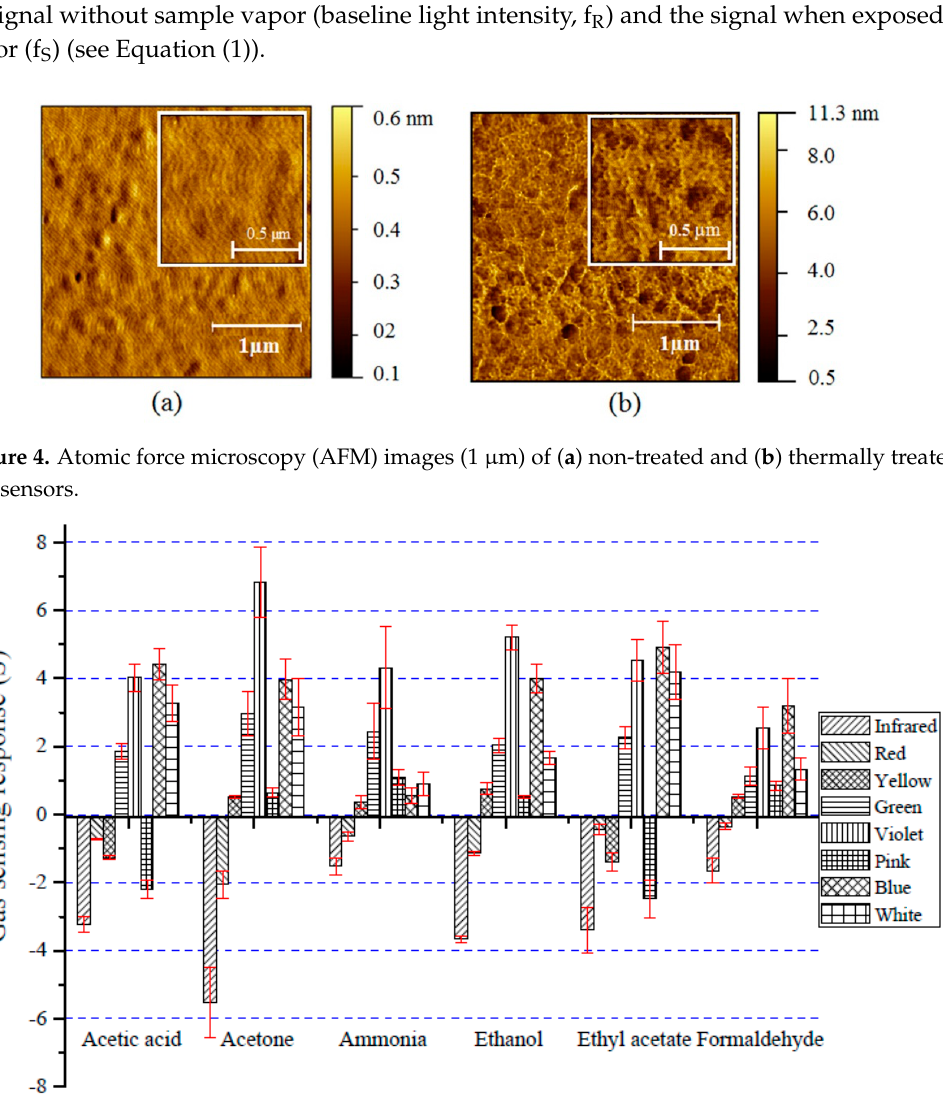
Figure 5. The gas sensing response (S) of thermally treated gas sensors toward VOCs in water (10%, volume/volume) under dynamic gas flow conditions.